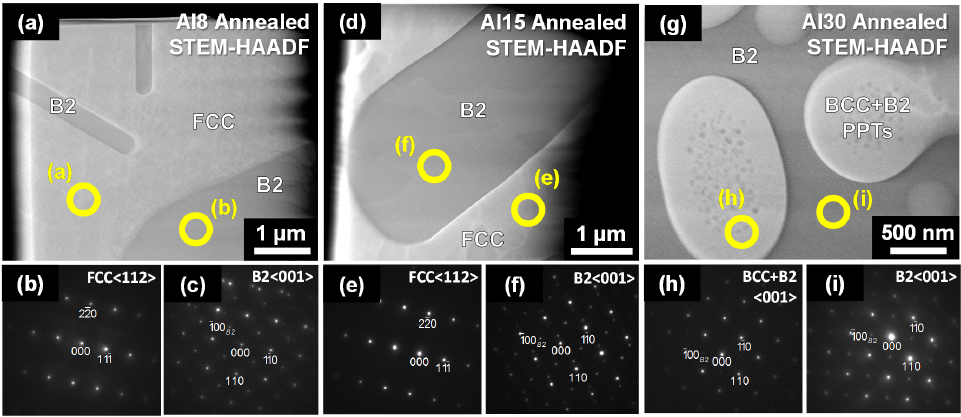
Figure 2. STEM ‐ HAADF images and corresponding selected area diffraction patterns (SADPs) for the annealed Al 8 ( a – c ); Al 15 ( d – f ); and Al 30 ( g – i ) HEAs. The open circles indicate the locations from which the SADPs were collected.